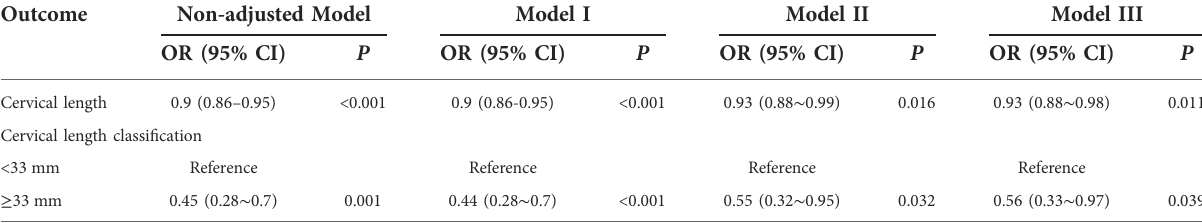
TABLE 3 Multivariate analysis for massive